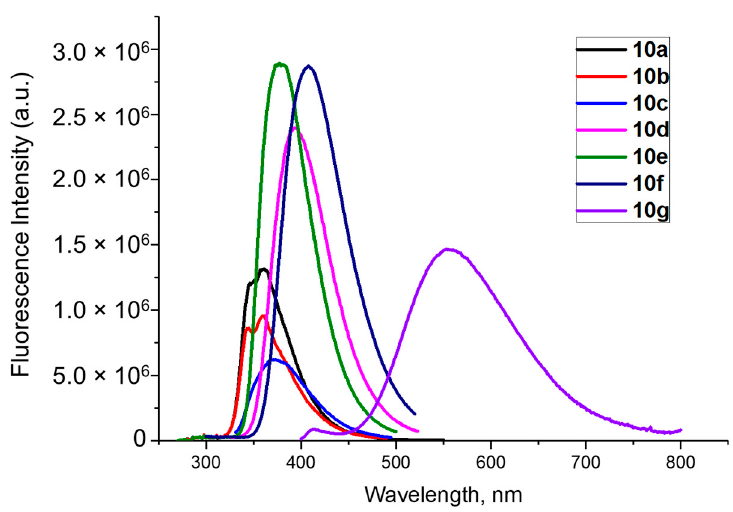
Figure 2. Absorption spectra of 10a – g in THF, C = 1 × 10 –5 M.